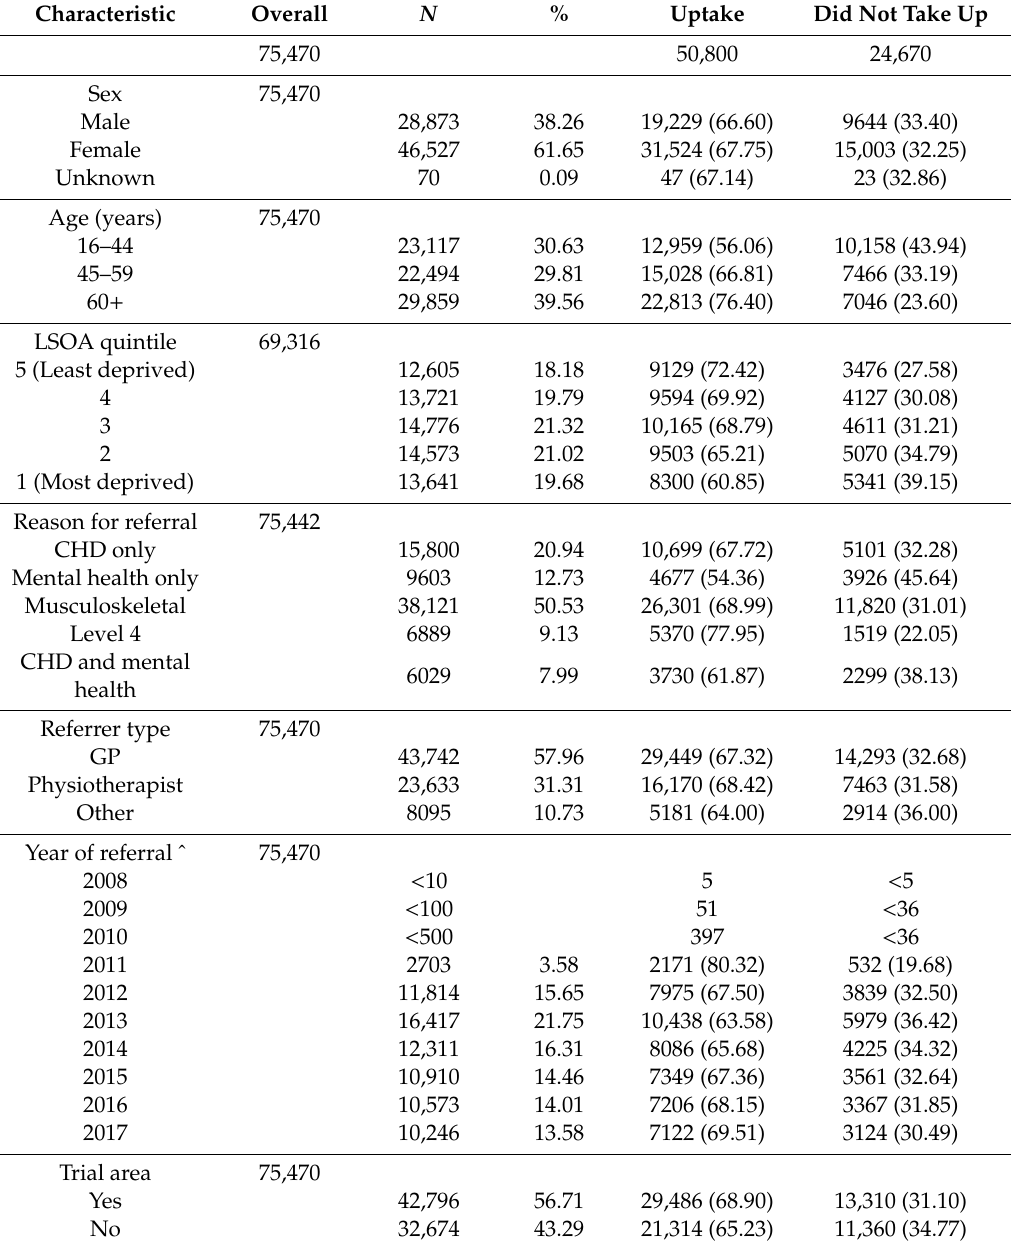
Table 2. Characteristics of patients according to scheme uptake ( N =